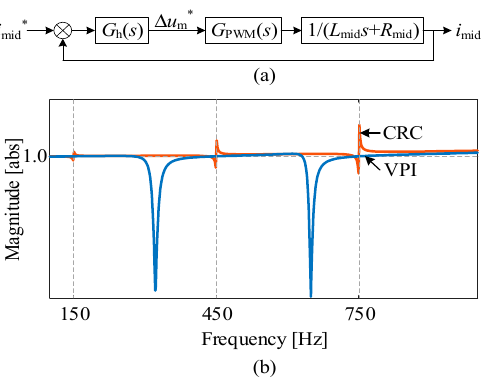
Figure 5. ( a ): Closed-loop control structure of the injected harmonic current; and ( b ) frequency response of the closed-loop transfer function.